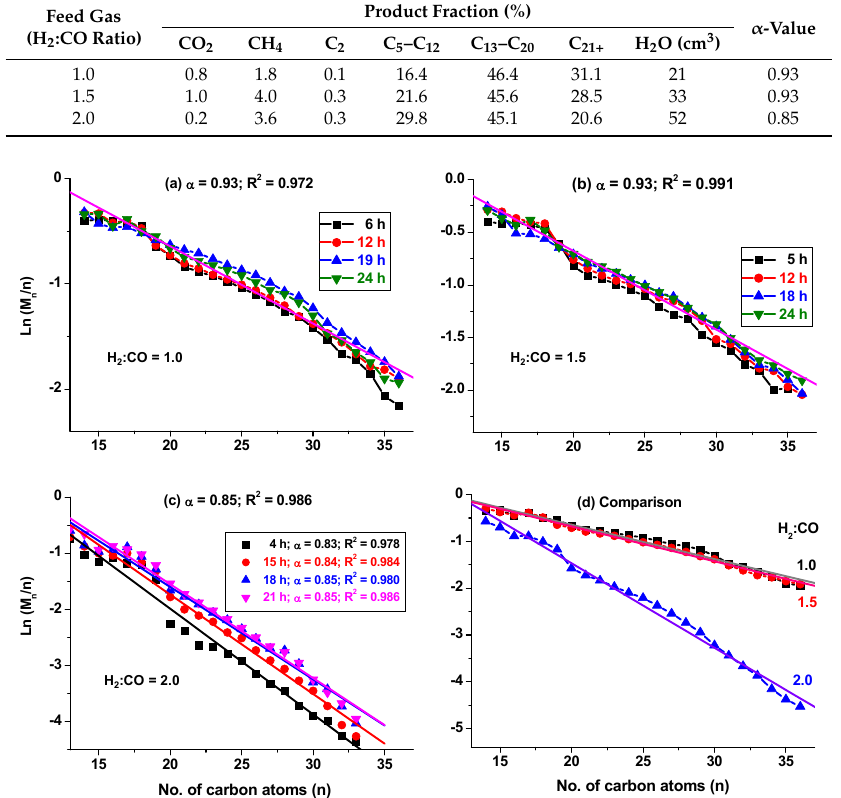
Figure 7. Plots displaying fast convergence and higher α‐ values for CO ‐ rich feed gases with H 2 :CO ratio of ( a ) = 1.0, ( b ) 1.5, ( c ) 2.0, and ( d ) their comparison after 24 h on stream at 220 °C, 2 MPa and GHSV of 3600 cm 3 ∙ g − 1 ∙ h − 1 .